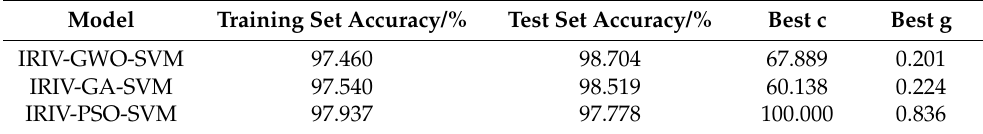
Table 5. Comparison of the IRIV-SVM models optimized by different intelligent optimization algorithms.